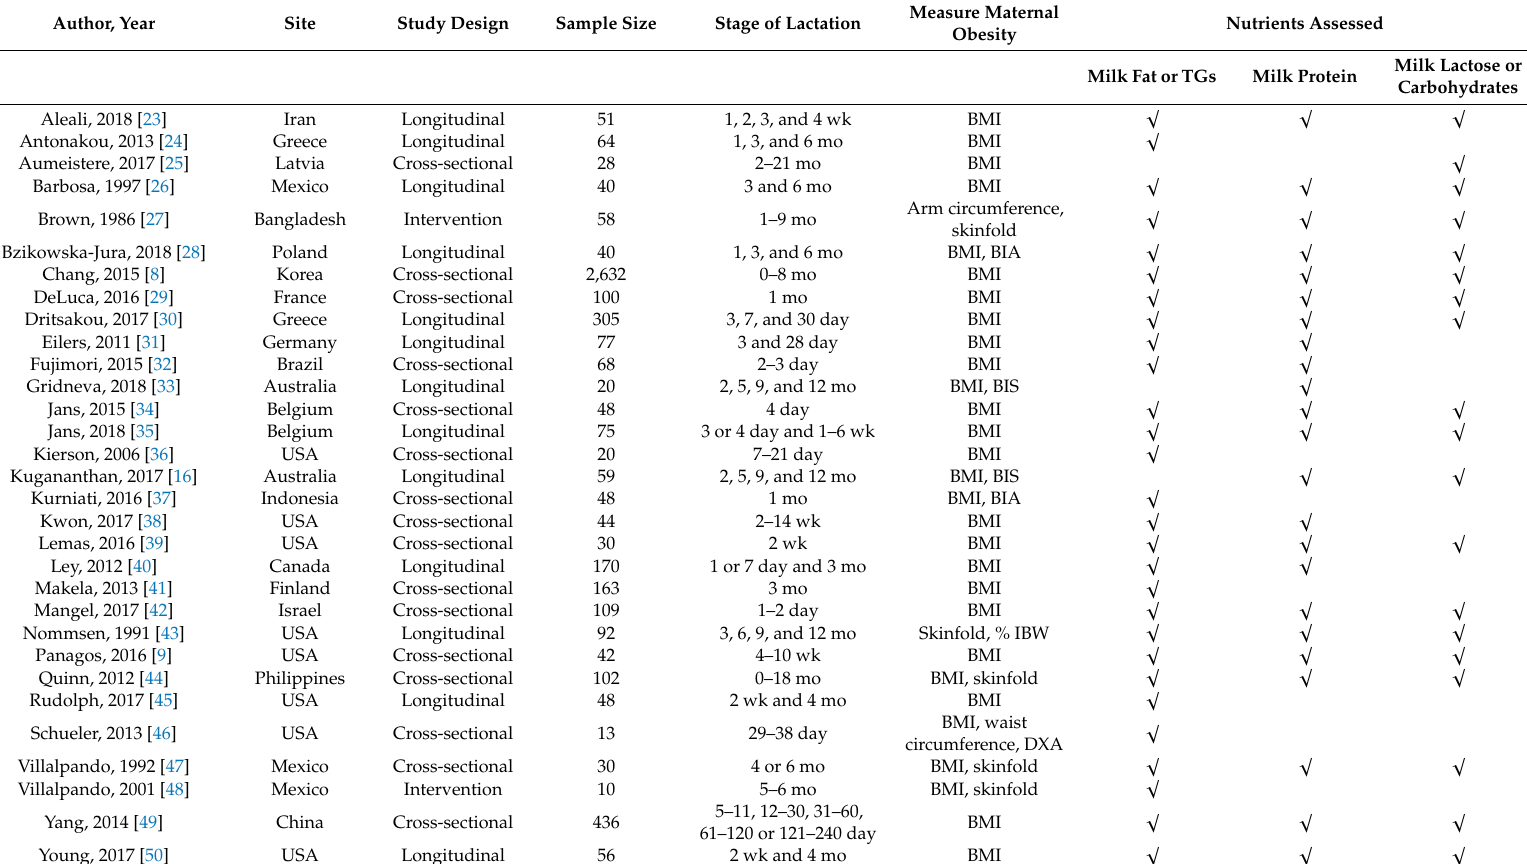
Table 1. Summary of studies of human milk macronutrient composition included in the systematic review 1